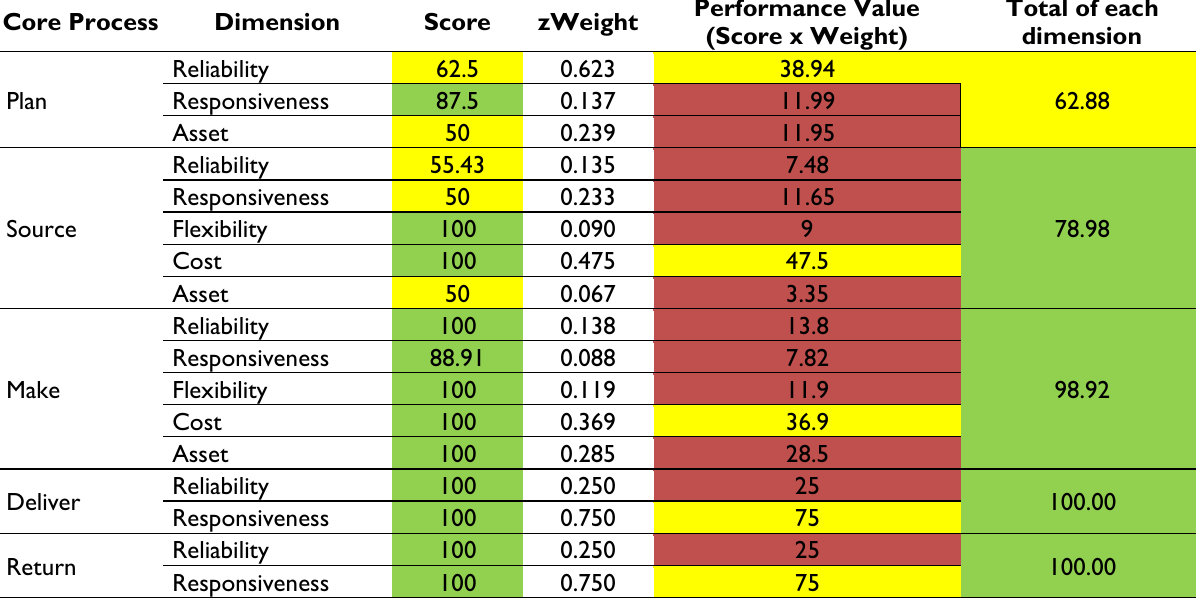
Table 12: Final Dimension Value Calculation Core Process